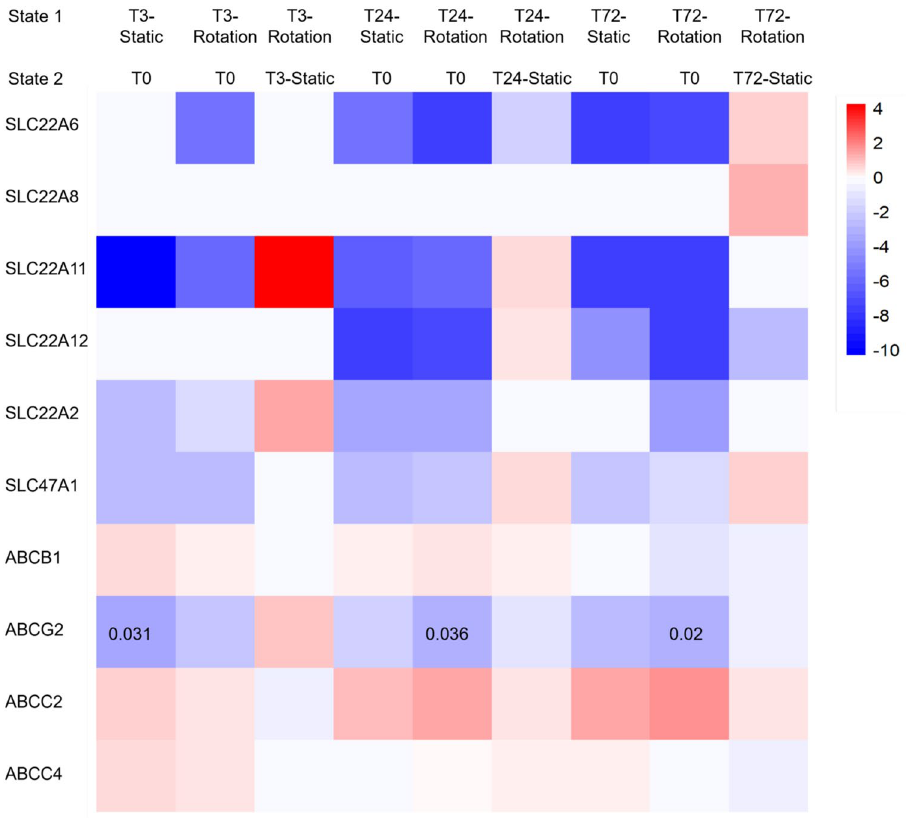
Figure 10. Changes in expression level among 10 renal transporter genes in RPTEC/TERT1 cells, rotation versus static conditions at 3-, 24-, and 72-h time points. Heatmap represents log2(fold change state1/state2) values. The heatmap was created in R v.3.6.2 1 (https:// www.R- proje ct. org/) using package pheatmap v.1.0.12 2 (https:// CRAN.R- proje ct. org/ packa ge= pheat map). FDR q values are indicated for the 3 significant differentially expressed states. White color (log 2 (FC) = 0) indicates DE genes with “NOTEST” status, where not enough alignments have been present for testing. Alternate names for the transporters in the heatmap include: organic anion transporter 1 (OAT1: SLC22A6), organic anion transporter 3, (OAT-3: SLC22A8) organic anion transporter 4 (OAT-4: SLC22A11), urate anion exchanger 1 (URAT1: SLC22A12), organic cation transporter 2 (OCT-2: SLC22A2), multidrug and toxin extrusion proteins 1 (MATE1: SLC47A1), multidrug resistance protein 1 (MDR-1: ABCB1, also known as Pgp), breast cancer resistance protein (BCRP: ABCG2), multidrug resistance